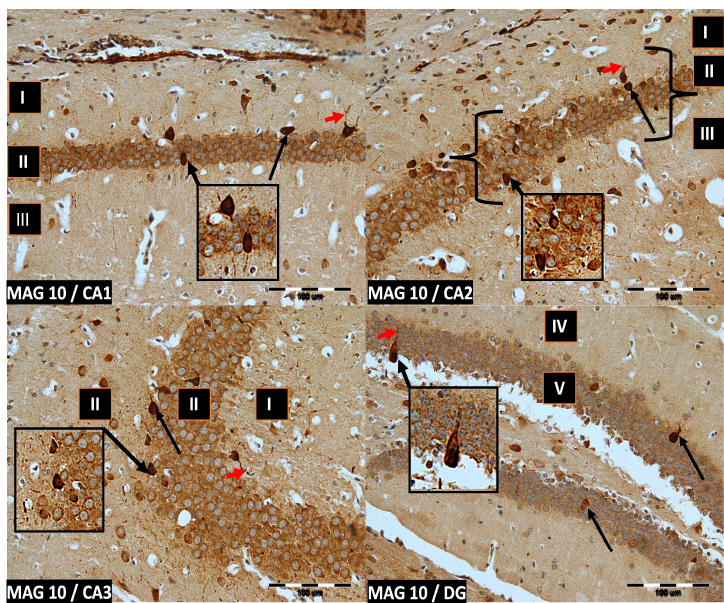
Figure 3. Group MAG10. Immunoreactivity of PV-IR neurons in the fields CA1–CA3 and the DG of the mouse hippocampus was observed. I. the marginal layer, II. the pyramidal layer, III. the multiform layer, IV. the molecular layer, V. the granular layer. The arrows indicate PV-IR neurons (black arrow) and PV-IR nerve fi bers (red arrow) in the hippocampus. Magni fi cation ×20 .